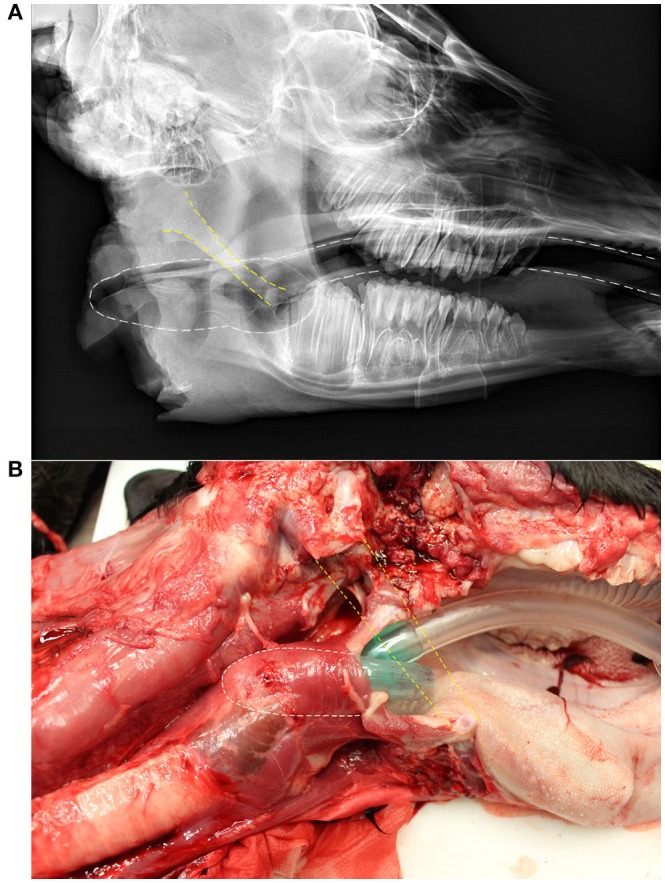
Lateral radiograph (A) and a dissected calf (B) showing the position of a laryngeal mask airway (LMA), the Solus® size 4. Yellow dashed lines indicate the position of the stylohyoid bone, which has been removed in (B). White dashed lines indicate the position of the LMA.